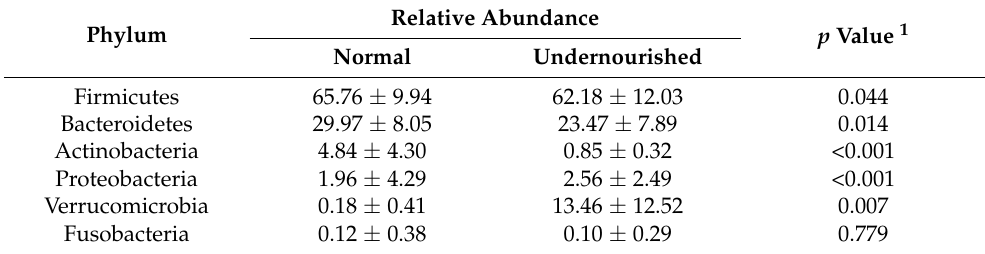
Table 3. Phylum level of gut microbiota composition of 40 Indonesian subjects.